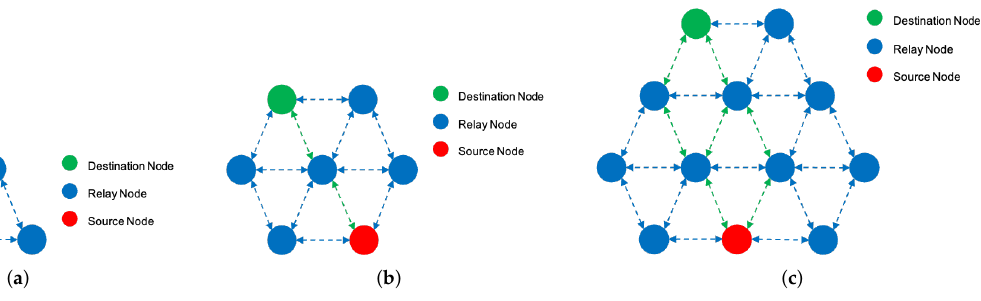
Figure 6. Three different network topologies. ( a ) One hop to Destination. ( b ) Two hop to Destination. ( c ) Three hop to